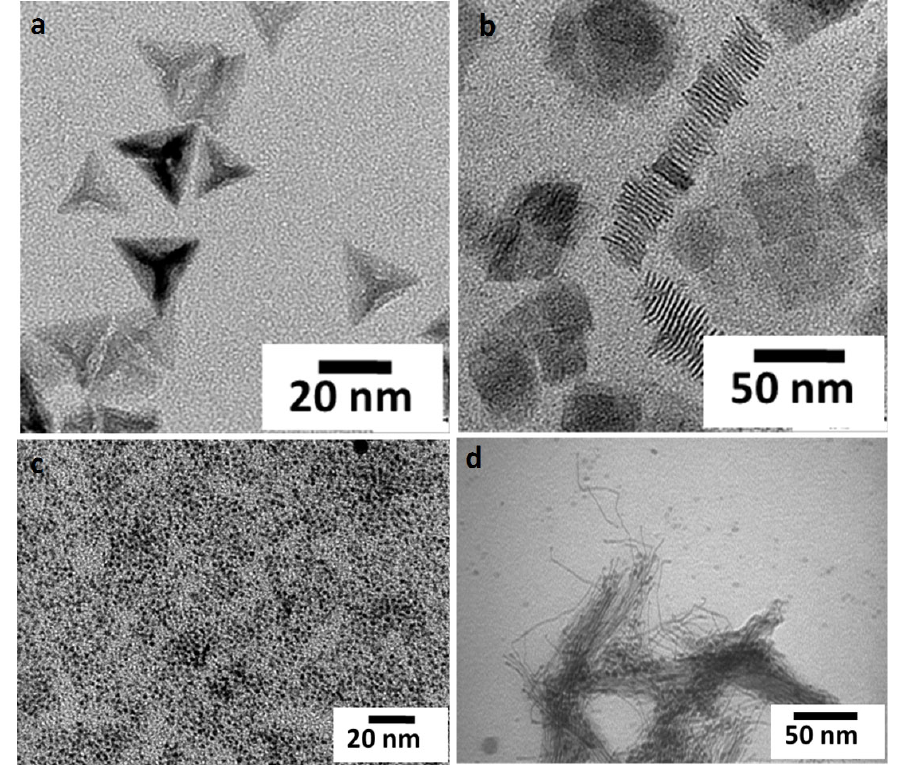
Figure 4 - TEM images of ( a ) pyramids-like cubic CoO nanoparticles, ( b ) samarium oxide nanoplates, ( c ) ultra-small FePt spherical nanoparticles, and ( d ) FePt